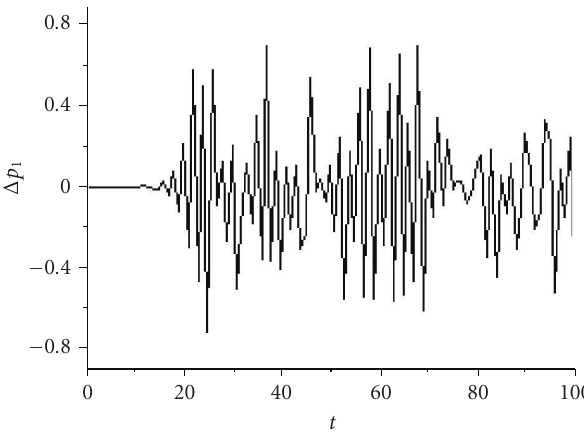
Figure 4.8 . Sensitivity to initial conditions of p 1 .